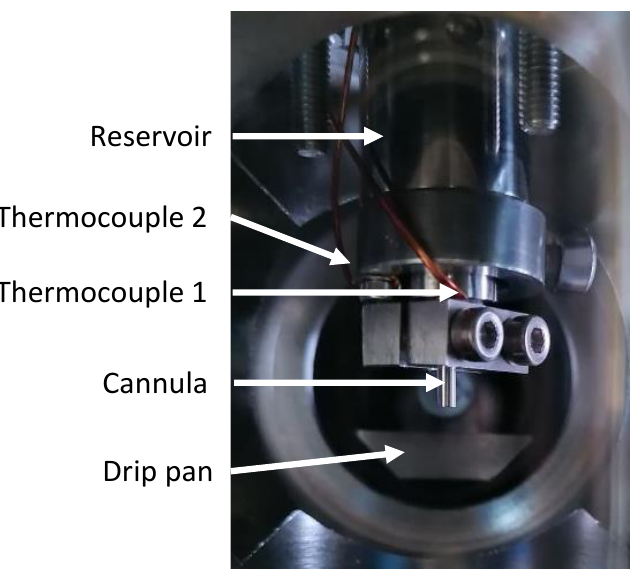
Figure 4. View into chamber for pendant drop measurements (note the two thermocouples attached to the cannula for accurate and independent temperature readings).